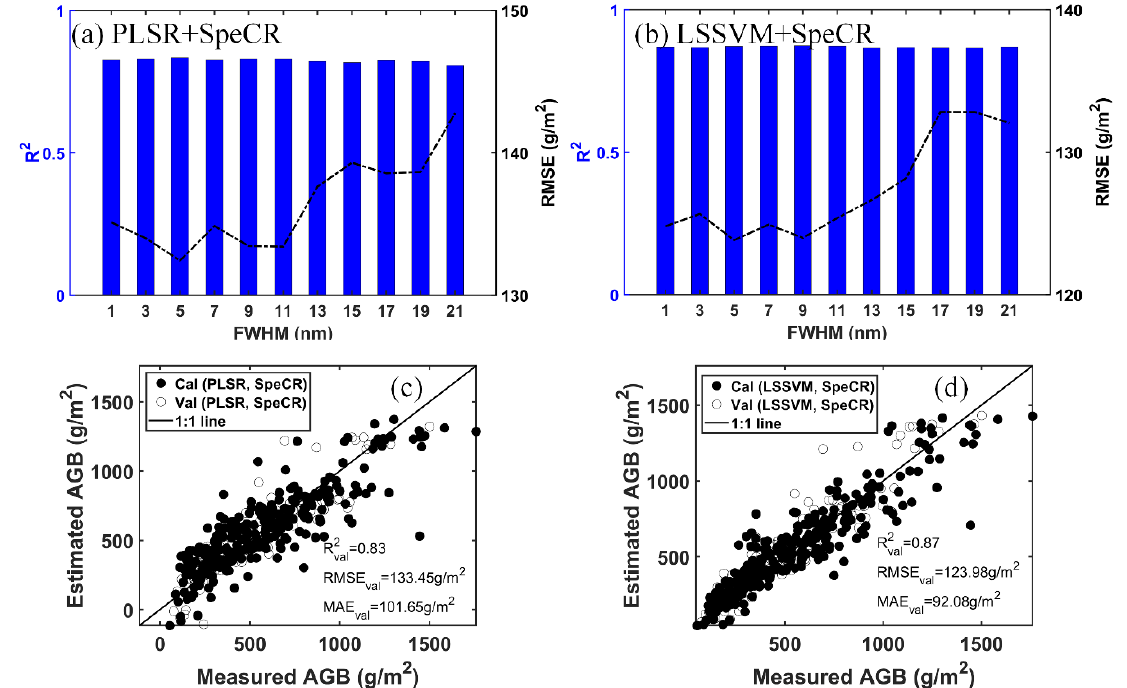
Figure 4. Predictive performance of the continuum removal of red-edge spectra (SpeCR) for winter wheat biomass estimation. Change of the predictive performance of SpeCR using PLSR ( a ) and LSSVM ( b ) under different bandwidths. Predictive performance of the SpeCR using PLSR at the optimal bandwidth (FWHM = 5) ( c ) and using LSSVM at the optimal bandwith (FWHM = 9) ( d ).